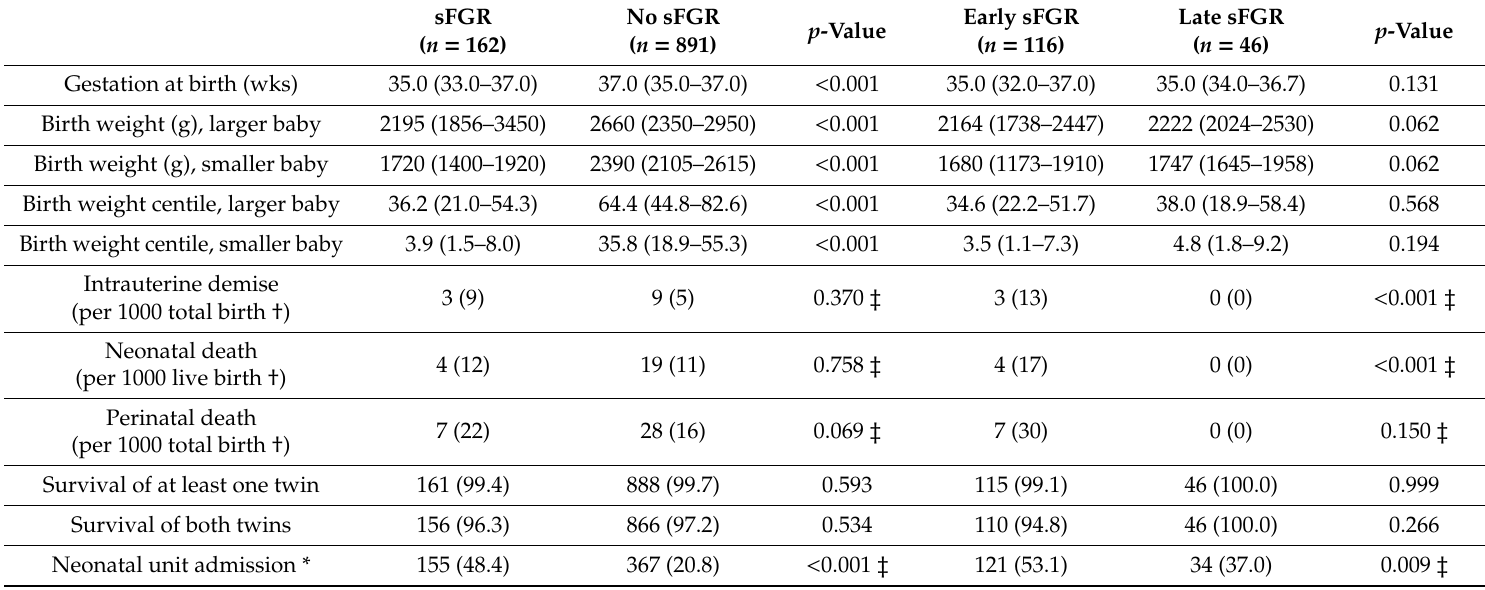
Table 5. Perinatal outcomes in dichorionic twin pregnancies according to whether they were complicated by sFGR or not according to the ISUOG diagnostic criteria in the whole cohort and stratified according to the gestational age at diagnosis. Data are shown as number (%) or median